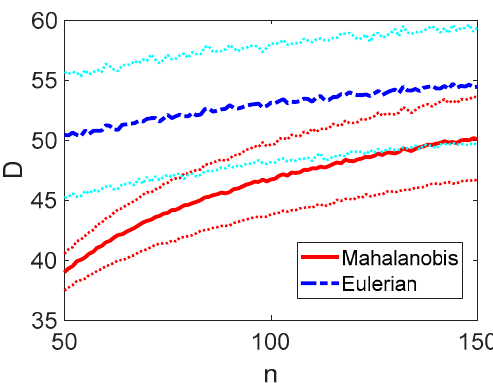
Figure 13. Averages of the estimated Mahalanobis distances (red) and true Eulerian distances (blue) for the Maxima of a 30-dimensional multivariate Gaussian, as a function of the sample numerousness n , considering 1000 Monte Carlo repetitions. ± σ confidence intervals of the estimates are also given in cyan (Eulerian) and red (Mahalanobis).